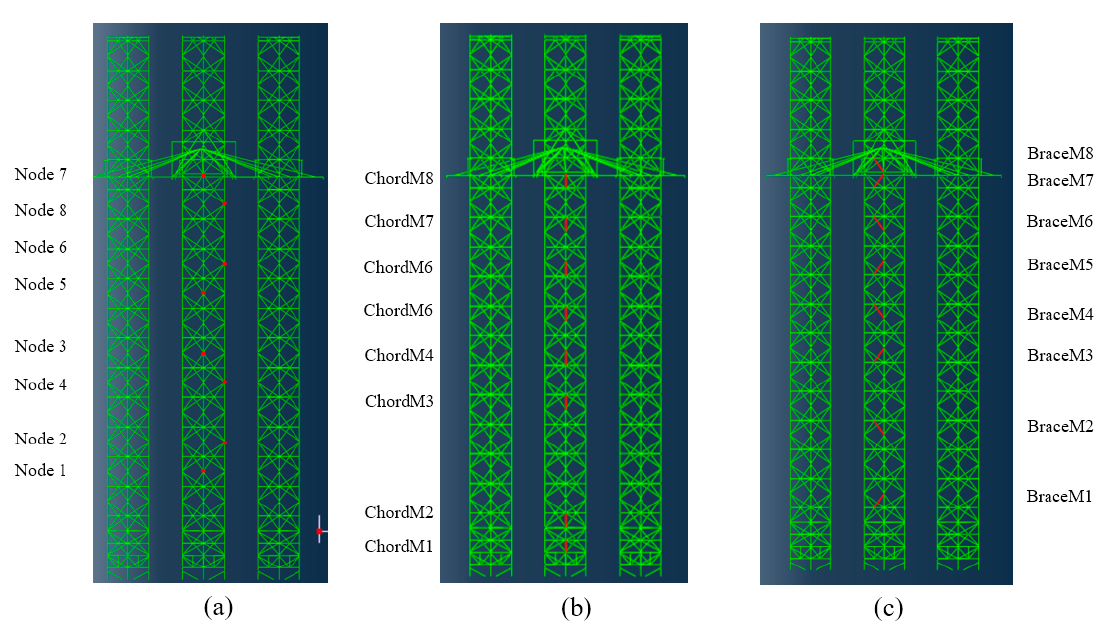
Figure 6. Location of ( a ) selected nodes, ( b ) chord members, and ( c ) bracing members on forward legs of the SEU for validation comparison (ChordM1 stands for chord member 1, BraceM1 stands for bracing member 1).